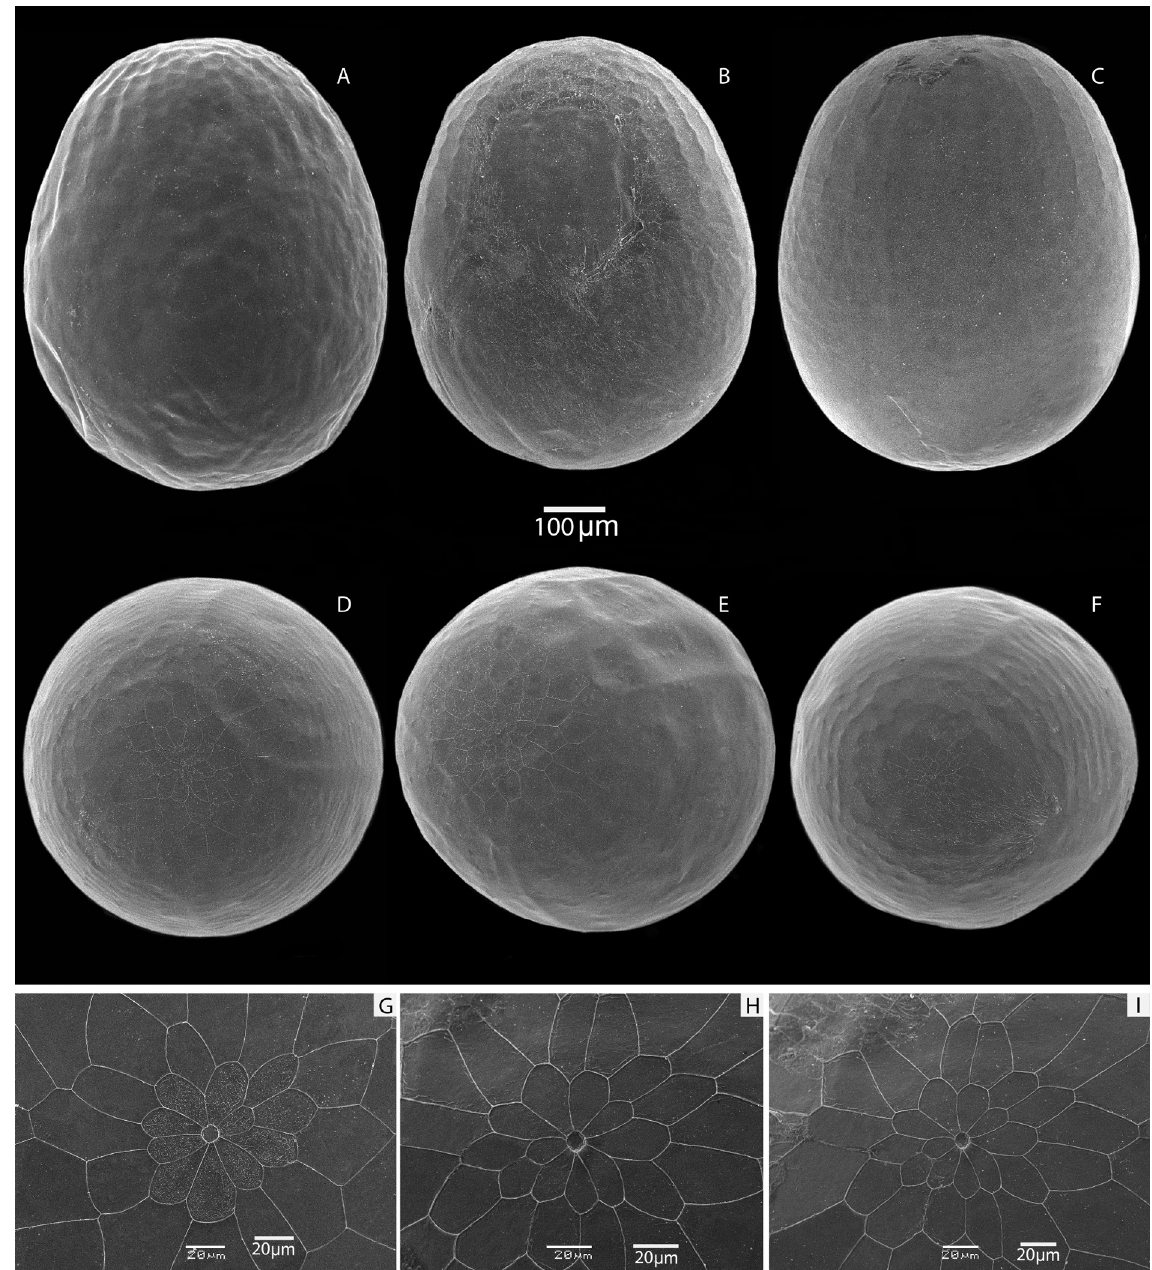
Fig. 20. Eggs of Melitaea timandra binaludica subsp. nov., Iran, Kuh-e-Binalud Mts. A–C . Lateral view. D–F . View from above. G–I . Micropile